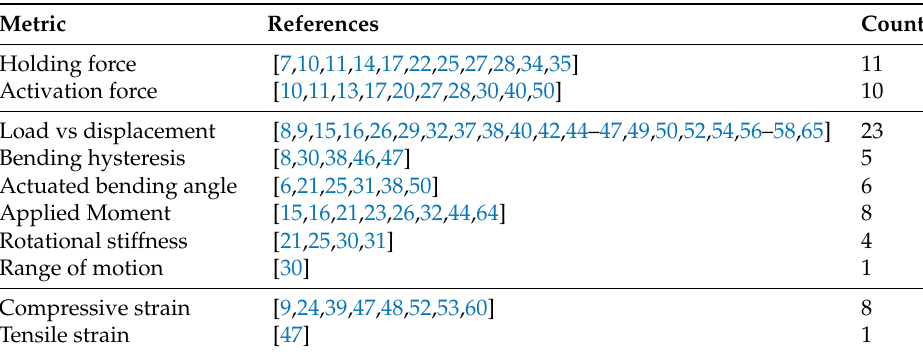
Table 9. Frequency of performance